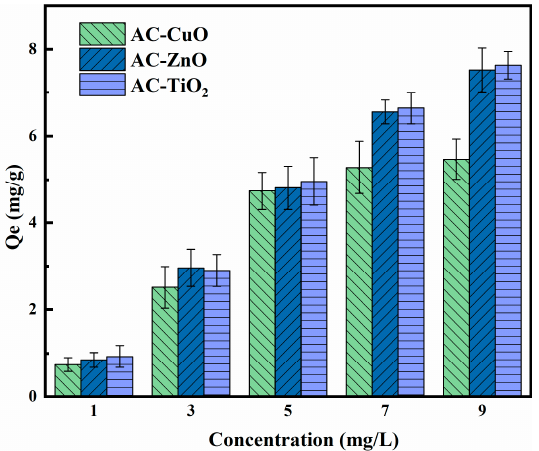
Figure 11. The effect of concentration on the removal of methylene blue (contact time = 90 min, dosage = 1 g/L, temperature = 25 ± 0.5 °C, initial pH = 7.00).